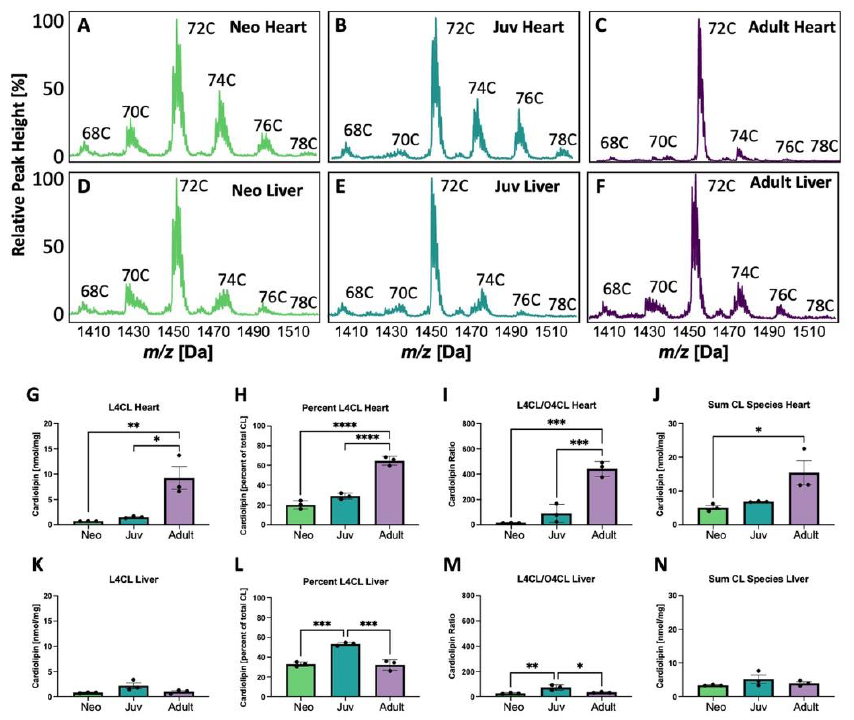
Figure 1. Cardiolipin (CL) changes with age in heart and liver. ( A – F ) Cardiolipin (CL) spectra in heart and liver from neonatal (Neo), juvenile (Juv), and adult rat heart and liver. C indicates the total number of side chain carbons on the CL in ( A – F ). Tetralineoyl CL (L 4 CL) levels ( G , K ) and percent ( H , L ) are quantified in heart and liver, respectively. Quantification of the ratio of L 4 CL to tetraoleoyl CL (O 4 CL) in heart ( I ) and liver ( M ) and the sum of CL species in heart ( J ) and liver ( N ). In ( G – N ), * p < 0.05, ** p < 0.01, *** p < 0.001, **** p < 0.0001; N = 3 separate animals; error bars represent standard error of the mean.